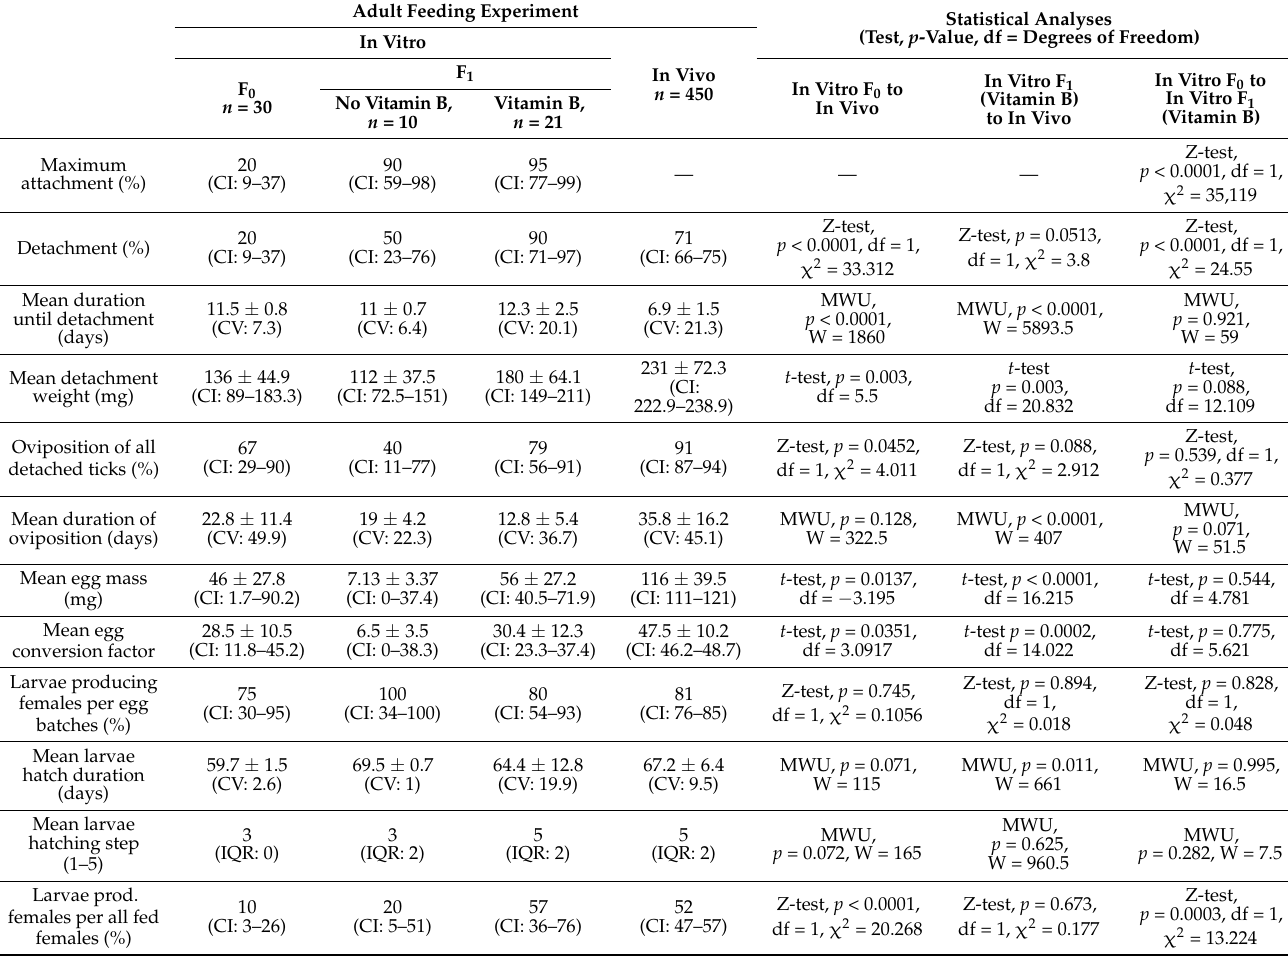
Table 1. Artificial feeding of F 0 and F 1 females in comparison to in vivo. Artificial feeding of 30 F 0 -female I. ricinus ticks from in vivo origin compared to artificial feeding of F 1 -in vitro generation female ticks in water bath with and without vitamin B components and to in vivo tick feeding on calves. Adult Feeding Experiment Statistical Analyses (Test, p -Value, df = Degrees of Freedom)In Vitro F 1 In Vivo In Vitro F 0 to In Vitro F 1 In Vitro F 0 to n = 450F 0 In Vitro F 1 (Vitamin B) B)No Vitamin B, n = 30 In Vivo (Vitamin to In Vivo n =